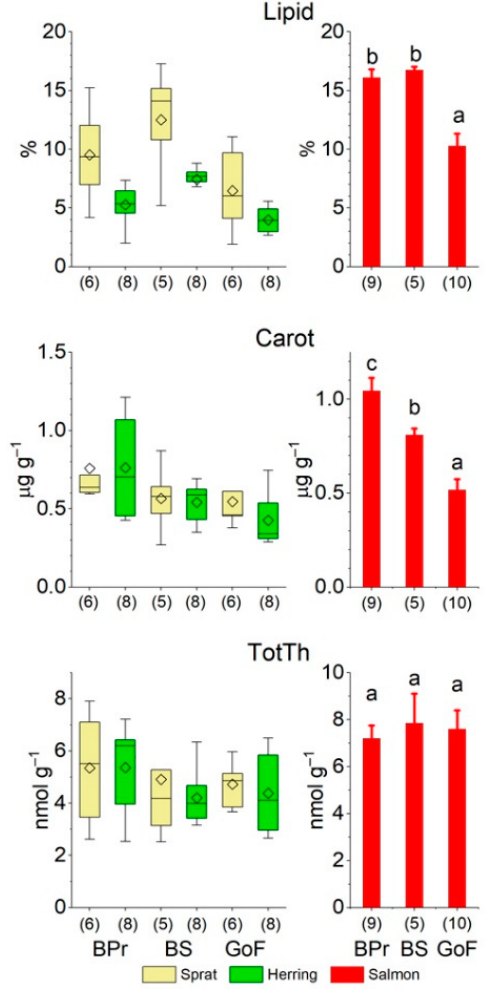
Figure 2. Total lipid content (Lipid) in the whole body of sprat ( Sprattus sprattus ) and herring ( Clupea harengus ) as box plots (with the samples of different ages in the fall and spring combined) and salmon ( Salmo salar ) (right column, mean ± SE, in the late fall), and the concentrations of total carotenoids (Carot) and total thiamine (TotTh) in sprat and herring, and in the muscle of salmon, from the three areas of the Baltic Sea, the Baltic Proper (BPr), the Bothnian Sea (BS), and the Gulf of Finland (GoF). Different letters denote significant ( p < 0.05) differences between the areas in salmon. In the box plots, whiskers depict 1 × SD, upper and lower parts of the boxes 25 and 75% of observations, horizontal lines the median value, and diamonds the mean concentrations. The number of observations is given in parentheses; sprat and herring pools are each composed of 7–133 individual fish.